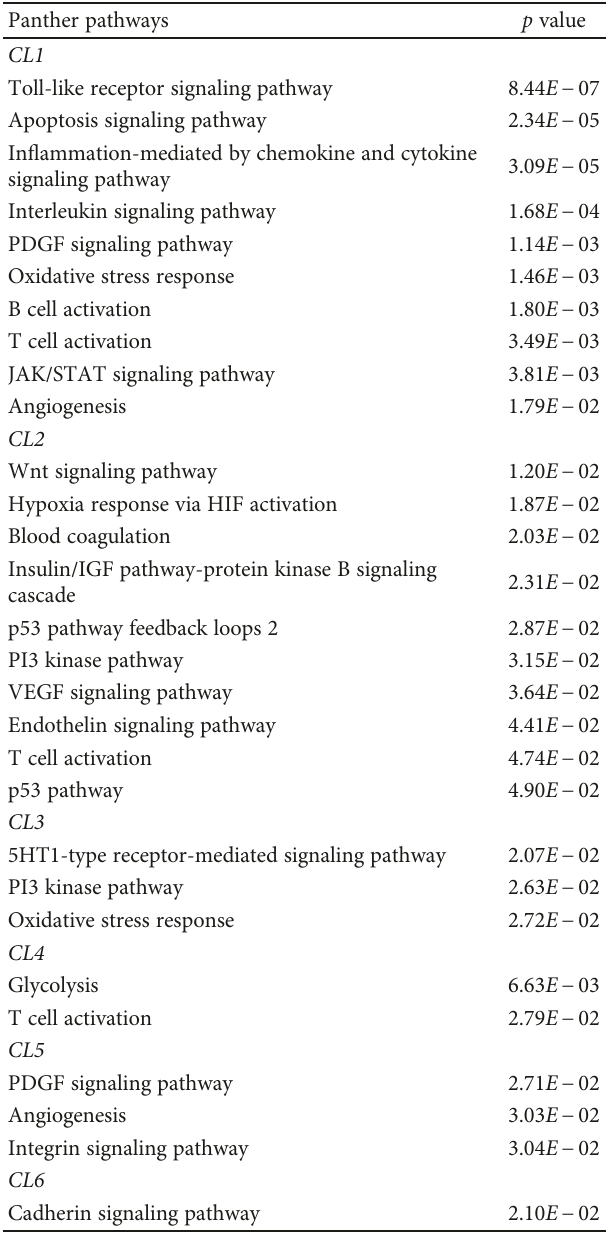
Table 4: Pathways enriched in DEGs targeted in each